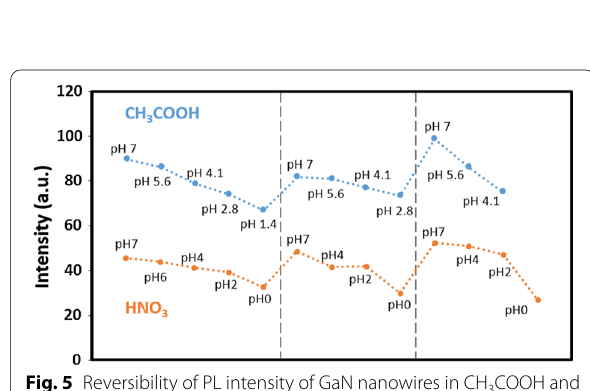
Fig. 5 Reversibility of PL intensity of GaN nanowires in CH 3 COOH and HNO 3 with various pH values